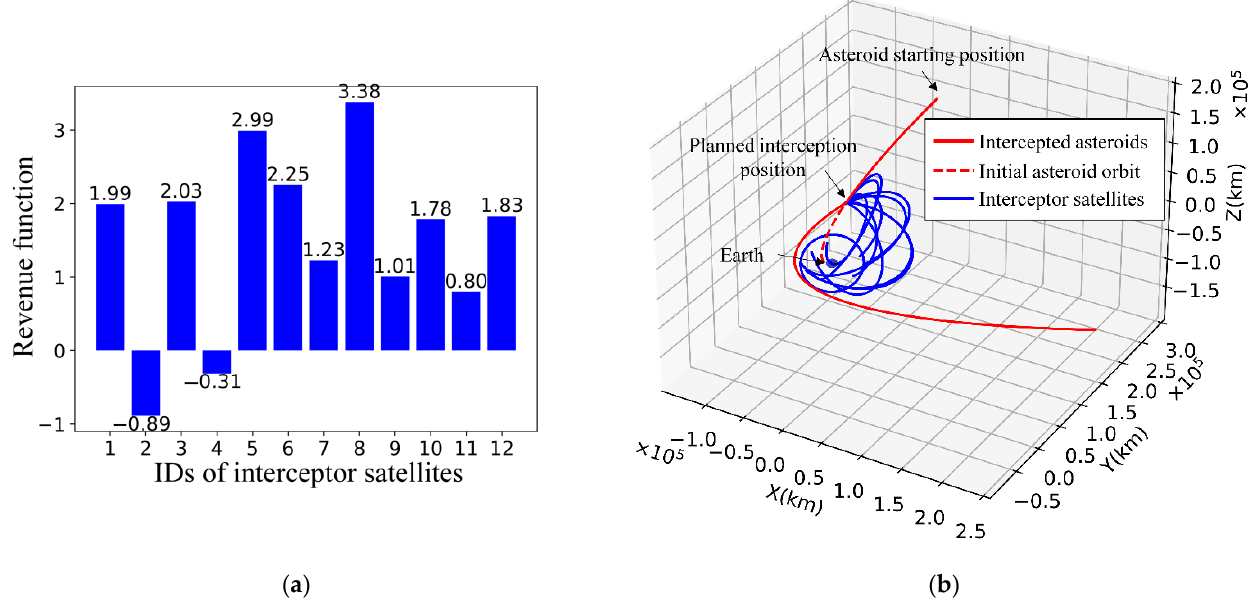
Figure 9. Simulation results when i 160,200s t = . ( a ) Revenue function. ( b ) Total trajectory diagram.